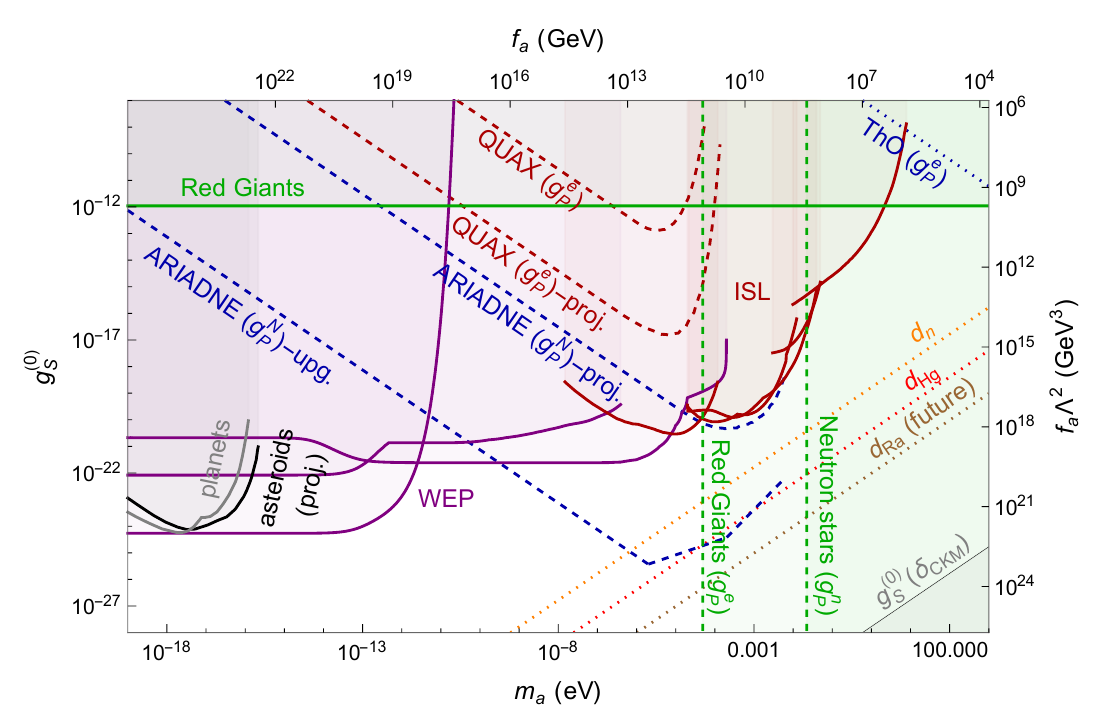
Figure 2 . Constraints on the isoscalar scalar axion-nucleon coupling in case of a down-quark chromo-EDM. The CP-even axial axion-nucleon coupling is chosen as in the DFSZ model with tan β = 1 . The WEP experiment limits are shown in purple, from top to bottom on the low end of axion mass the lines denote Eöt-Wash (2000) [103], Eöt-Wash (2008) [104], and the MICROSCOPE mission [102]. The inverse-square law (ISL) experiments limits are shown in red, from left to right the lines denote Irvine [105], HUST [108–111], Eöt-Wash [106, 107], Stanford [112], and IUPUI [113]. The astronomical bounds from planets [115] are shown in gray and the projected limits from asteroids [114] are shown black. The stellar cooling bounds are shown in green for Red Giants [118, 120] and neutron stars [121]. Note that the vertical line from Red Giants is a bound on g e which would be much weaker had we used the KSVZ model. The EDM limits are shown as P dotted lines, where orange corresponds to the neutron [3], red to Hg [1], brown to Ra [86], and blue to ThO [89]. The current and projected limits from QUAX [135] are depicted by red-dashed lines. The ARIADNE limits are shown in blue-dashed for the initially envisioned setup (labeled ‘proj.’) and a upgraded version (labeled ‘upg.’) [130–132]. The estimated size of g (0) arising from the SM S CKM phase is shown in gray at the bottom-right